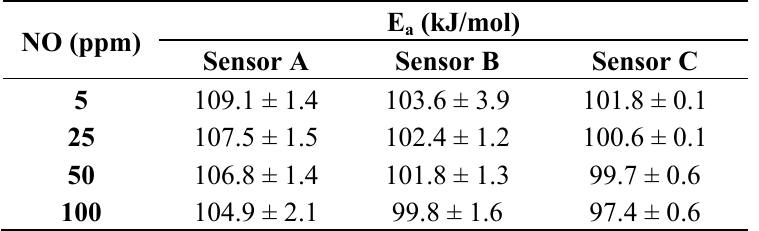
Table 1. Activation energy for various NO concentrations and sensors. Sensor A, B, and C have 50, 48, and 46% porosity,